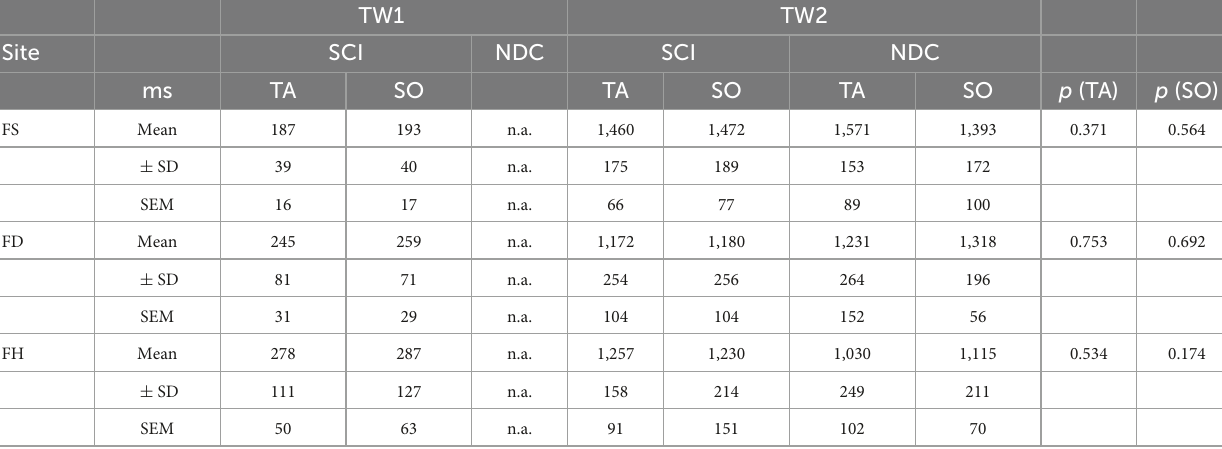
TABLE 3 Latencies of laser-evoked withdrawal reflexes.